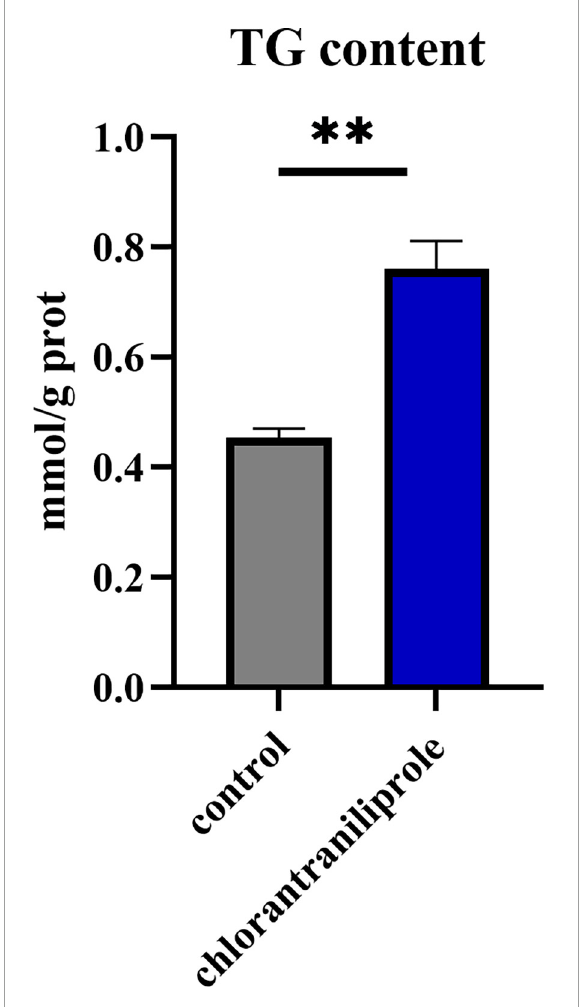
FIGURE1 The triglyceride content in the C-vs.-CH is detected by a TG kit. C represents four untreated control samples; CH represents four chlorantraniliprole-treated treatment group samples. Numbers are mean ± SEM ( n = 4). ** P < 0.01.